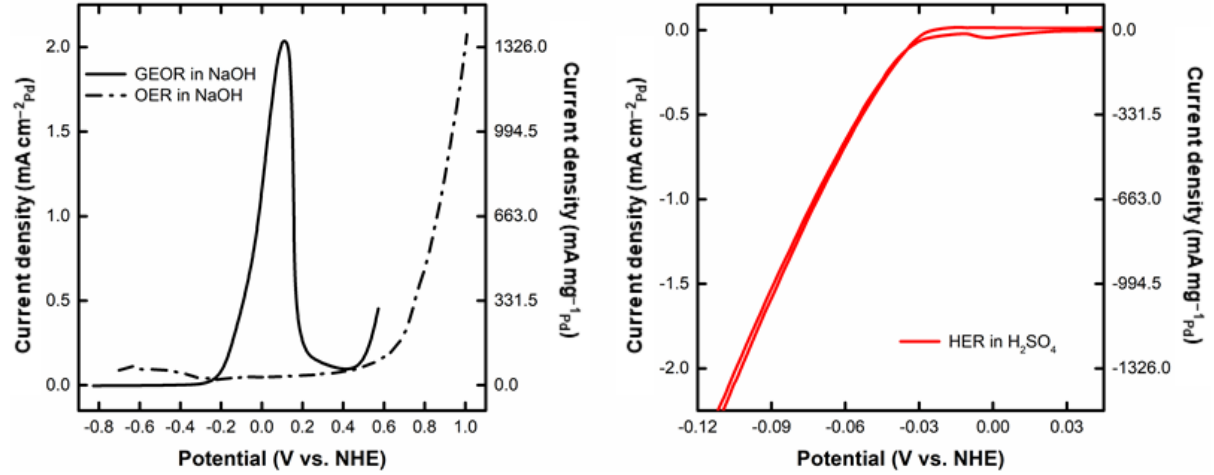
Figure 1. ( a ) Blank CV in 0.5 mol L − 1 H 2 SO 4 , and ( b ) Blank CV in 1 mol L − 1 NaOH. Arrows indicate the direction of the potential